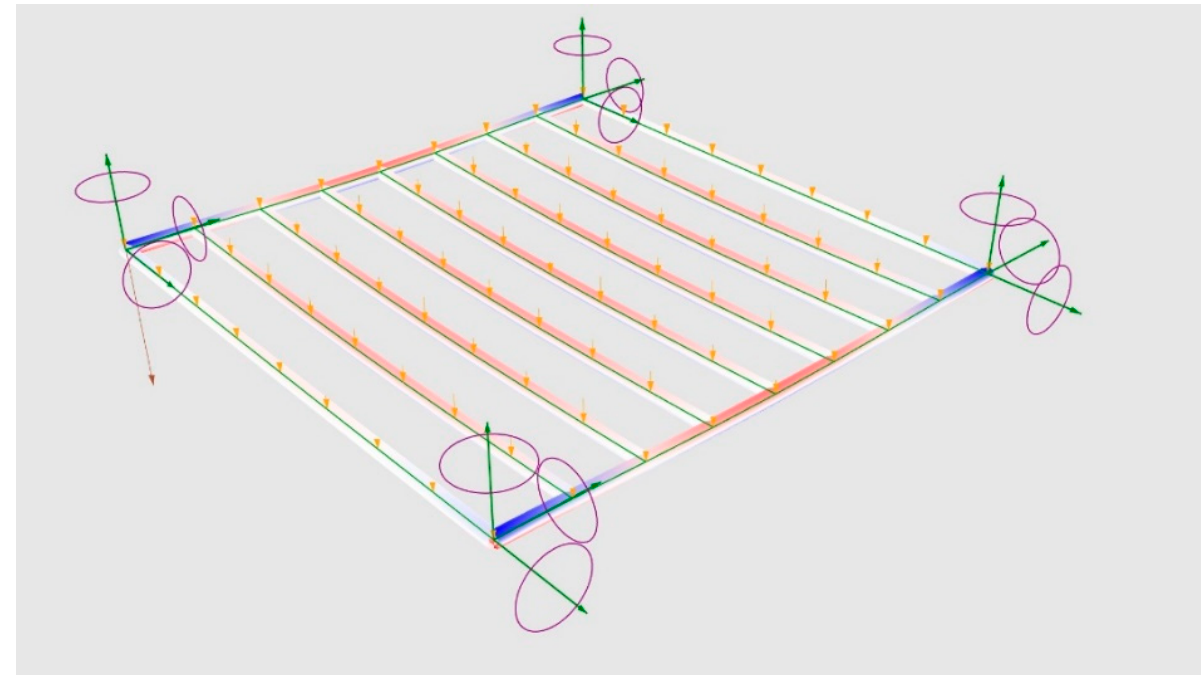
Figure 4. Simulation of supports and loads in Karamba3D.